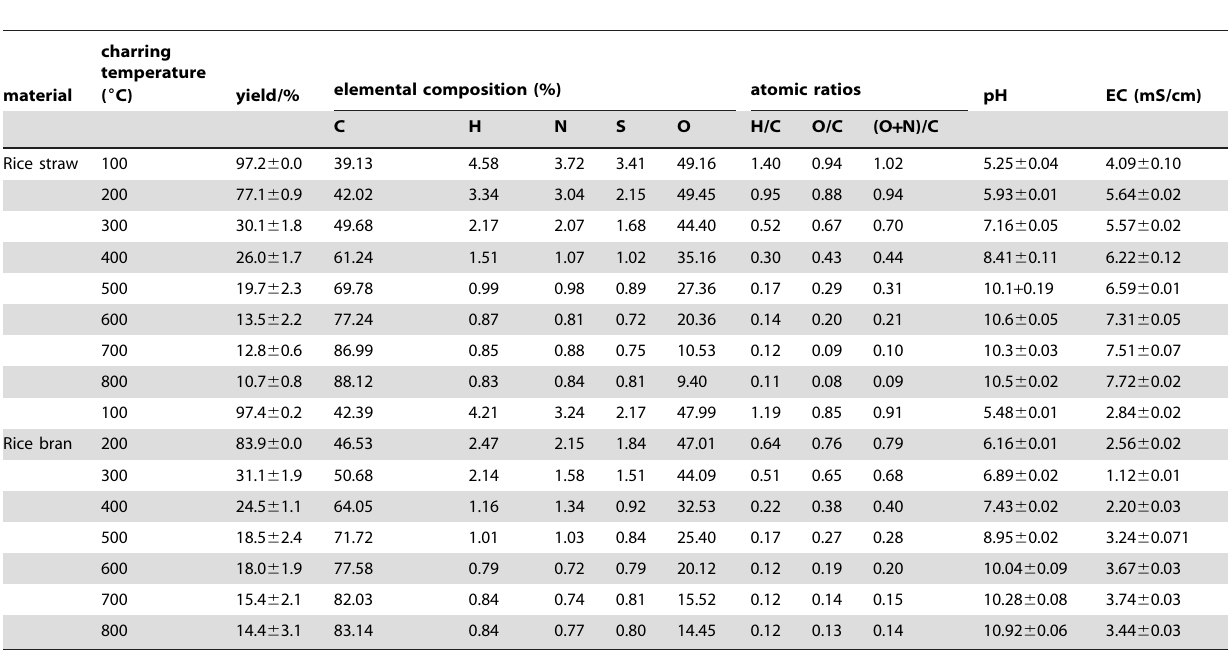
Table 1. Yields, elemental composition, atomic ratios, pH and EC of rice straw and rice bran derived biochars prepared at various charring temperatures. a